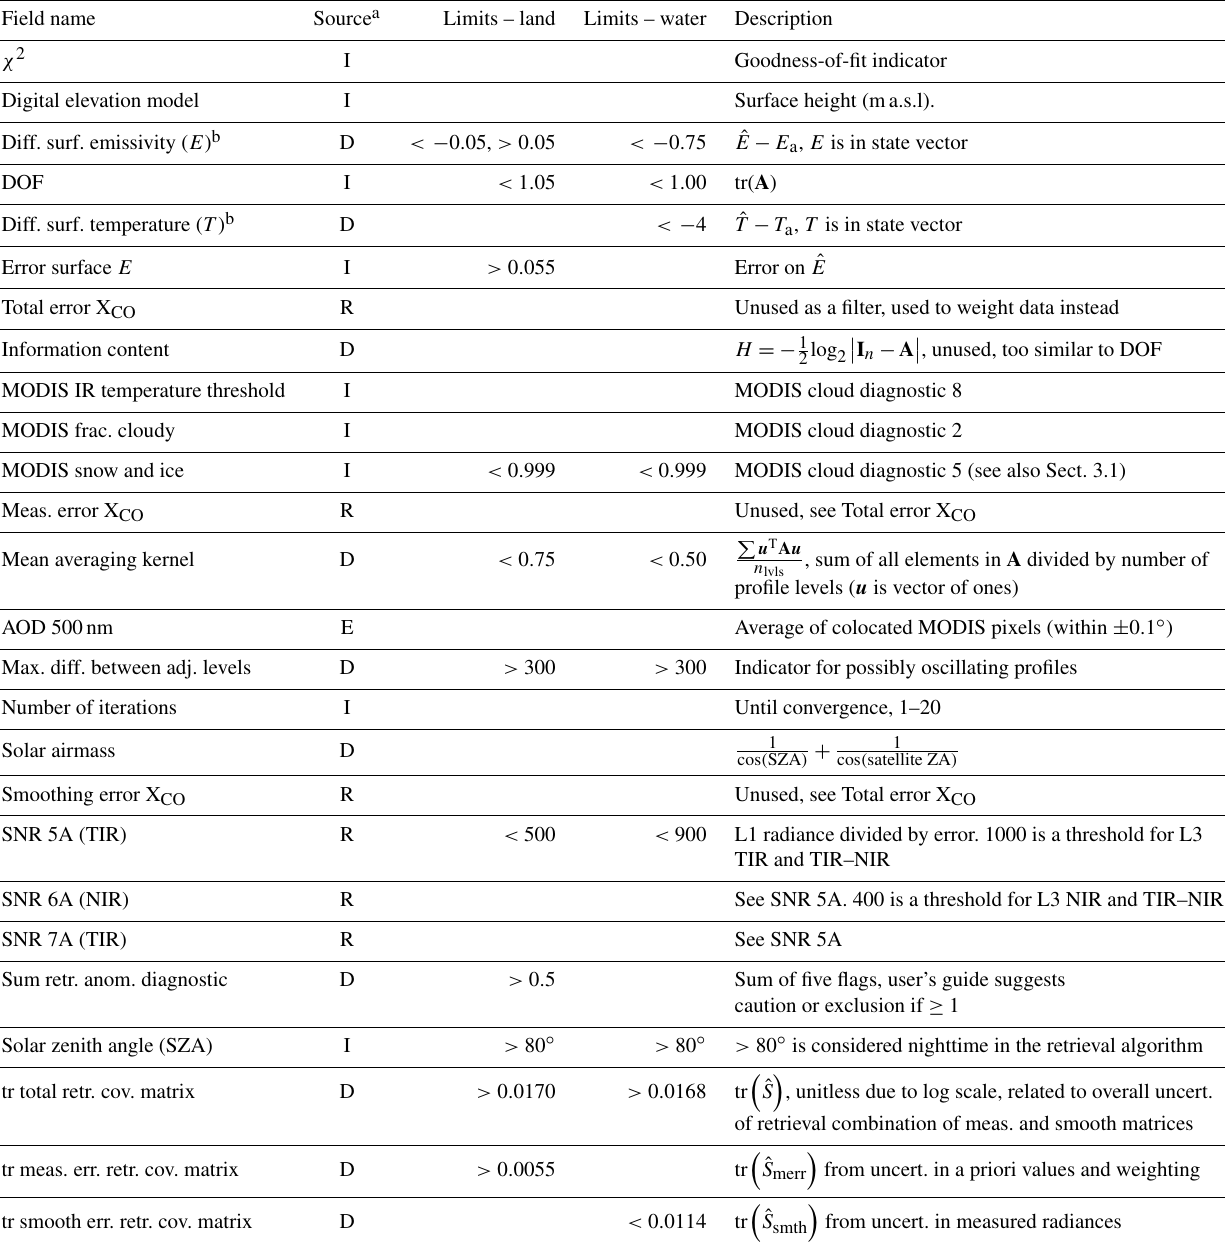
Table 3. Parameters in or related to MOPITT retrievals that we considered for filtering and bias correction. Data are excluded if any of the criteria below are met. Mixed surface-type soundings are also